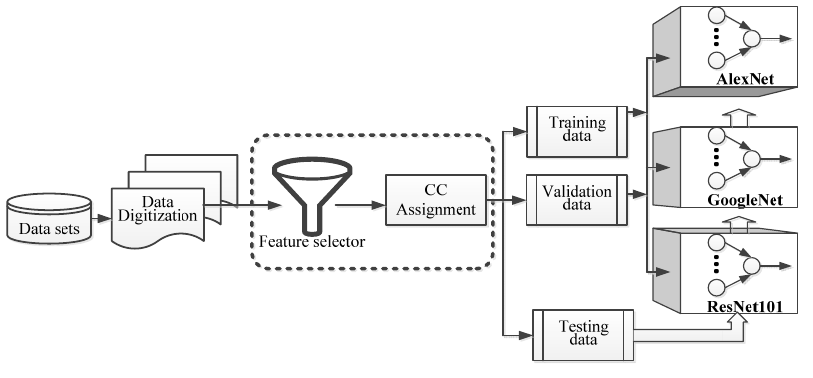
Figure 4. The block diagram of experiments.